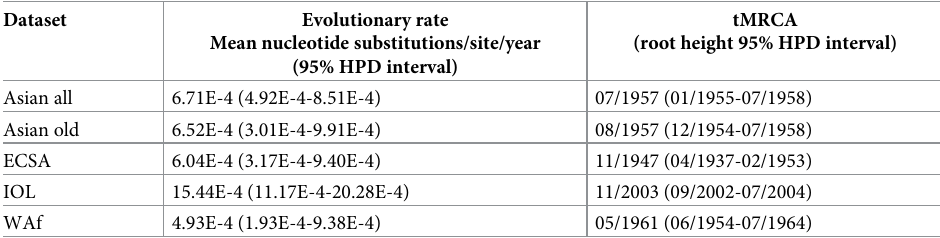
Table 2. Rate of nucleotide substitutions and tMRCAs of mayor CHIKV